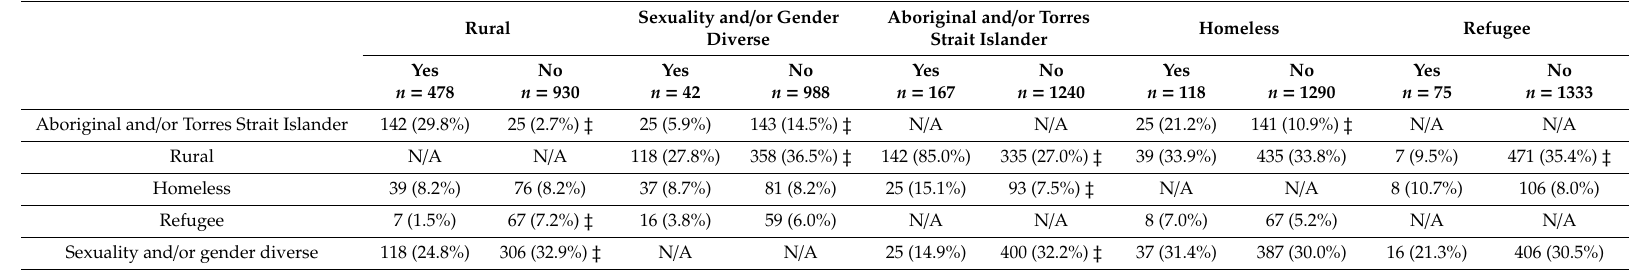
Table 1. Intersections between marginalised groups.